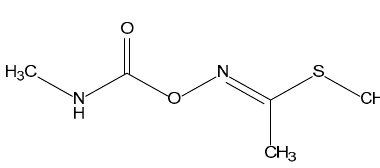
Figure 1. The chemical structure of methomyl.